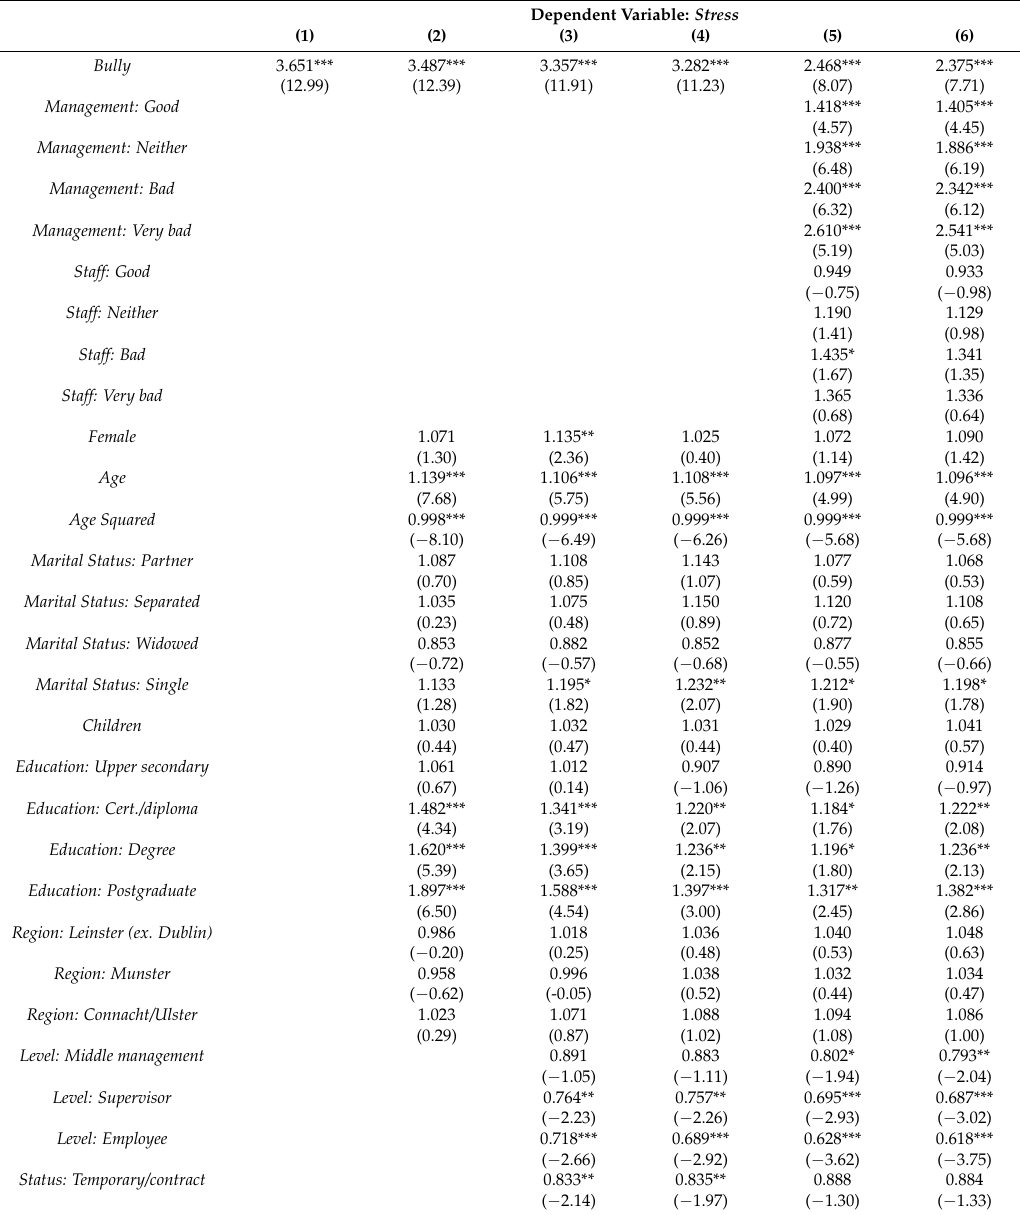
Table 3. Ordered logit model estimates (odds